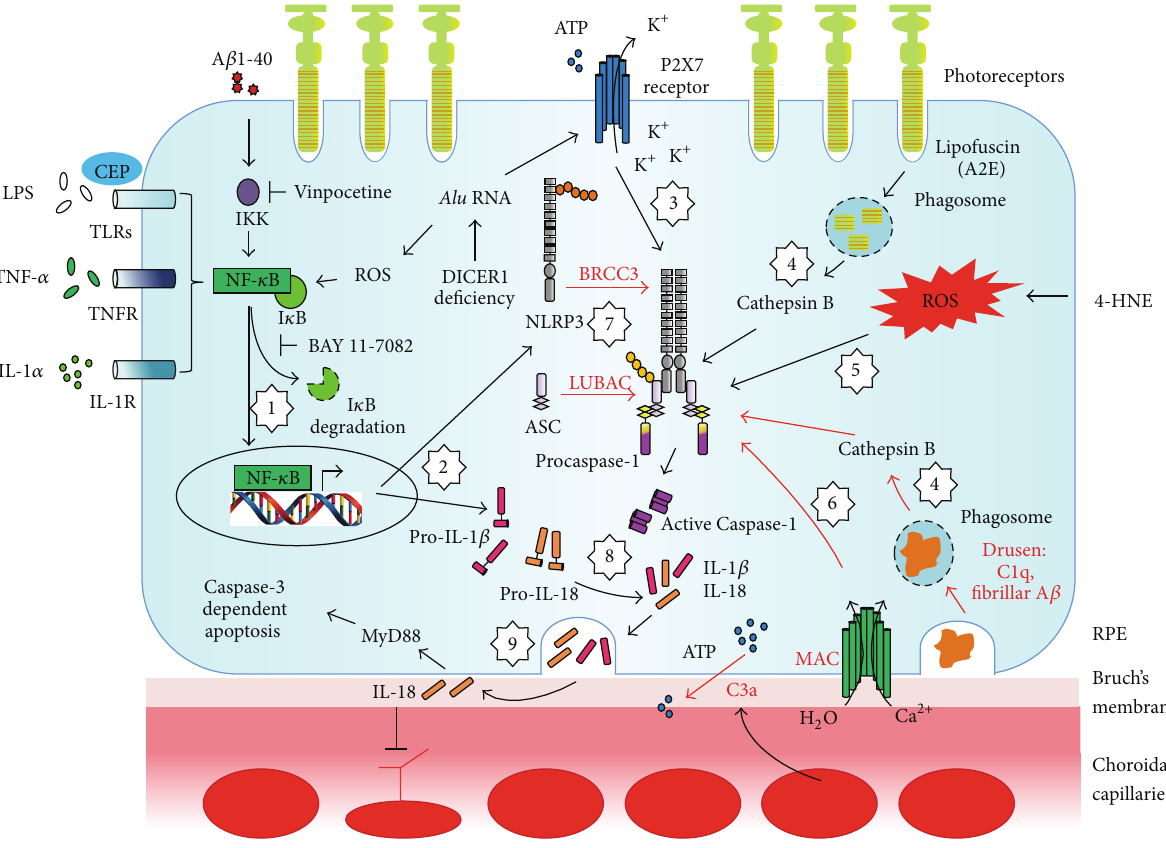
Figure 2: Current model of NLRP3 inflammasome activation in RPE. (1) Priming of the RPE by one of the following factors (LPS [17], TNF- 𝛼 [17], IL-1 𝛼 [17], CEP [18], and A 𝛽 1-40 [19]) is needed in order to activate the NF- 𝜅 B pathway, which can be specifically blocked by vinpocetine or BAY 11-7082 [19]. Intriguingly, DICER1 deficiency induced Alu RNA accumulation has also been demonstrated to prime NF- 𝜅 B signaling, independent of toll-like receptors (TLRs) [20]. (2) Once the NF- 𝜅 B pathway is active, it promotes the transcription of NLRP3 and pro-IL-1 𝛽 . (3–7) For the production of mature IL-1 𝛽 and IL-18; separate inflammasome components are assembled as a multiprotein complex triggered by one of the following mechanisms: K + efflux via P2X7 receptor activation in response to extracellular ATP accumulation or intracellular Alu RNA [20] (3); cytoplasmic cathepsin B release from destabilized phagolysosomes of lipofuscin/A2E [21] (4); ROS overproduction caused by 4-HNE [22] (5). Other NLRP3 inflammasome activation mechanisms that have been reported in immune cells but not validated in RPE cells are shown in red text and arrows. These include drusen components (C1q [18] and fibrillar A 𝛽 [23]) induced lysosomal damage (4), C3a triggered ATP efflux [24], MAC formation [25] (6), BRCC3-mediated deubiquitylation [26], and LUBAC-mediated ubiquitylation [27] (7). (8) Successful assembly of NLRP3 inflammasome triggers autoproteolysis of procaspase-1 into active caspase-1, which further oligomerizes to convert pro-IL-1 𝛽 and pro-IL-18 into bioactive peptides. (9) The biological significance of NLRP3 inflammasome activation is to release active IL-1 𝛽 and IL-18 into extracellular space through exocytosis. The secreted IL-1 𝛽 will facilitate inflammation process in the tissue whereas IL-18 will either promote caspase-3 dependent RPE apoptosis via MyD88 signaling or suppress neovascular vessels growth in thechoroid capillaries.